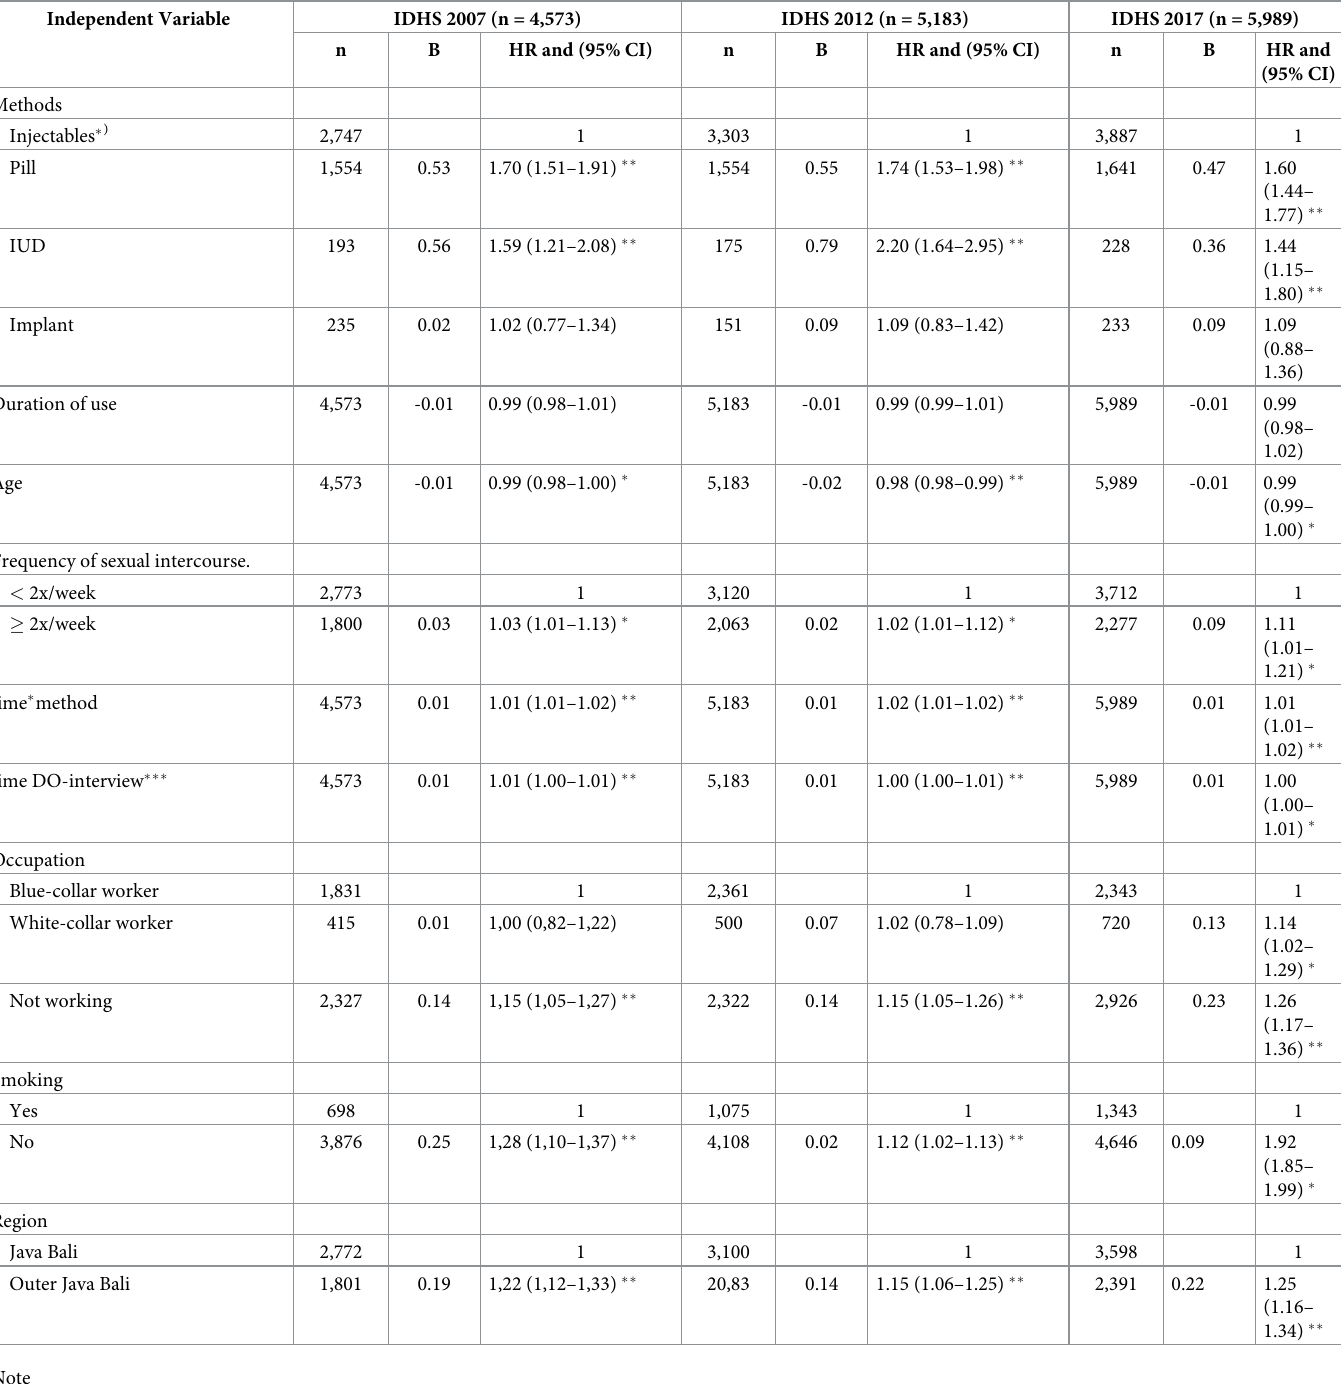
Table 4. Factors influencing fertility resumption after discontinuing the use of reversible contraceptives to conceive. Independent